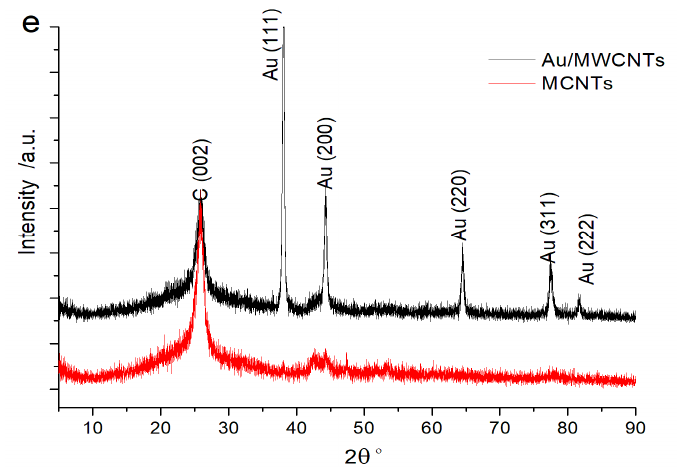
Figure 3. XRD spectra of Au/MWCNTs (black), MWCNTs (red).